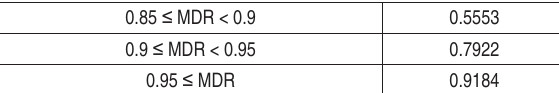
Table 2 (cont.). NFE model for marginal effect estimation